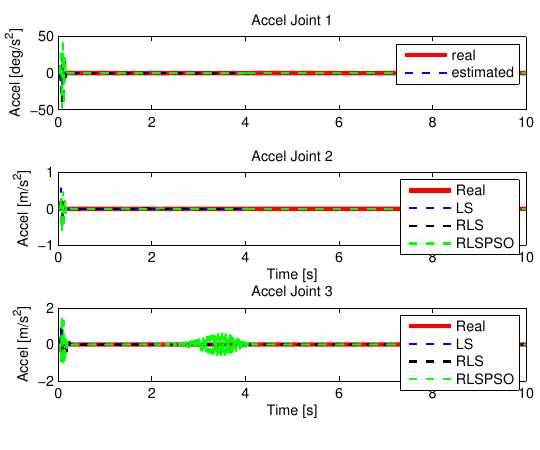
Figure 39. Speed identifications.